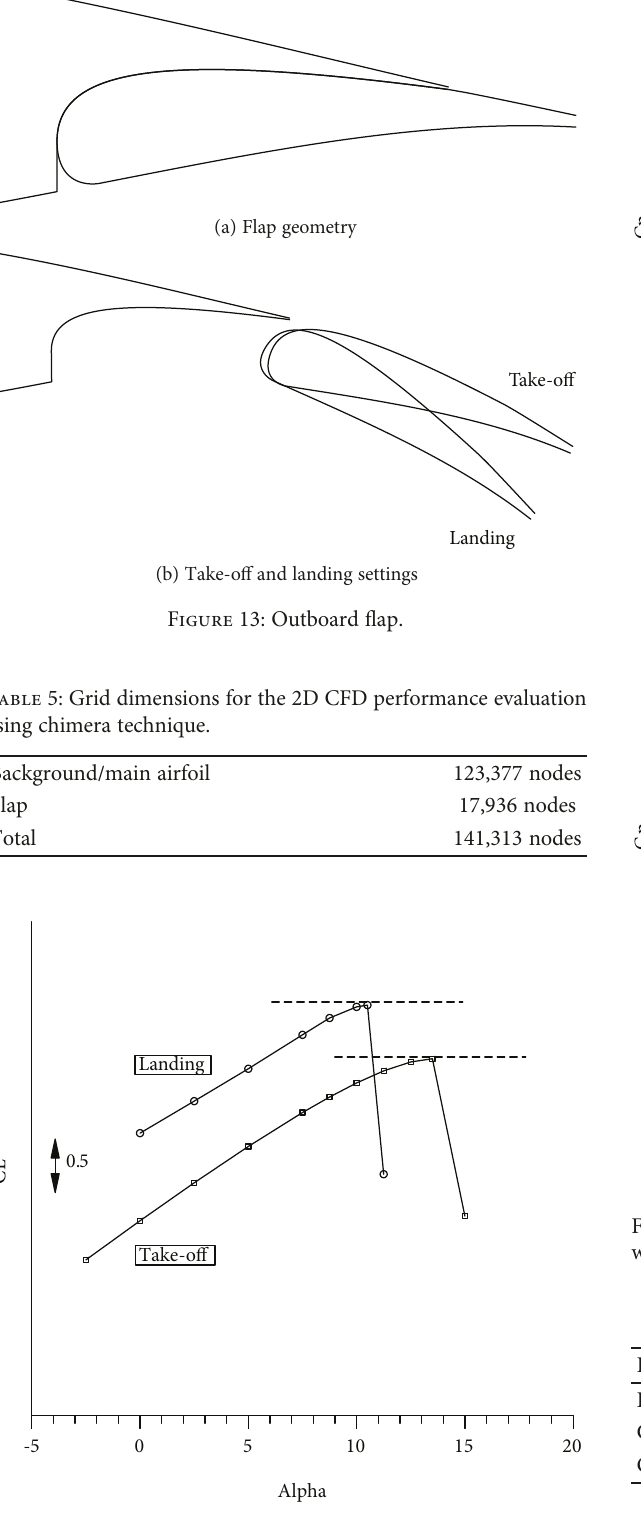
Figure 14: Computed aerodynamic performance of takeo ff and landing con fi gurations for the outboard wing section without the droop nose device (2D).